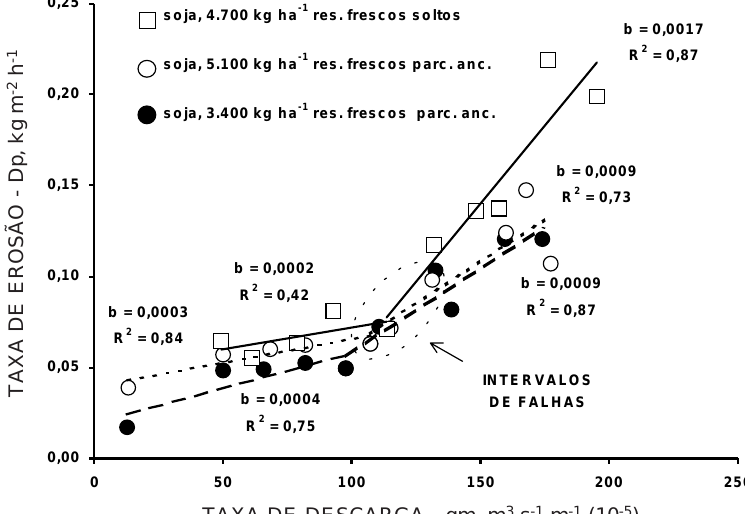
Figura 3. Relação da taxa média de erosão, Dp, com a taxa de descarga no ponto médio da parcela, qm, nos tratamentos com 5.100 e 3.400 kg ha -1 de resíduos de soja, ambos frescos e parcialmente ancorados,